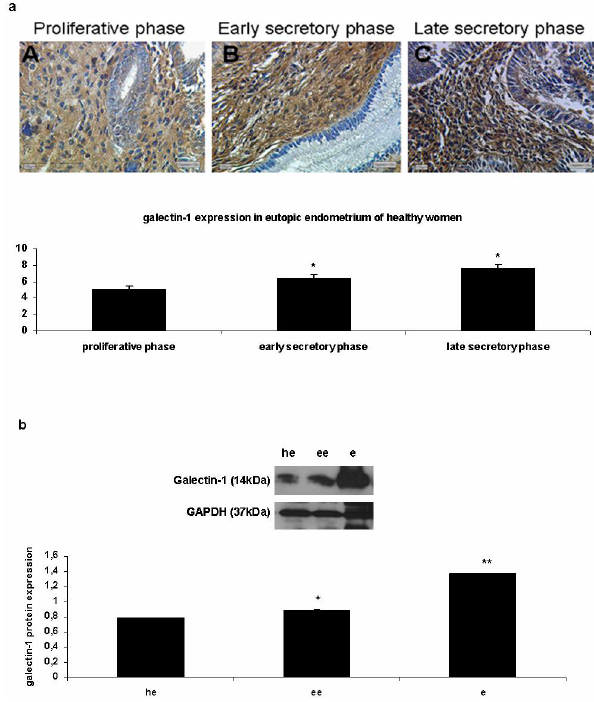
Figure 1. Galectin-1 overexpression in late secretory phase of eutopic endometrium and in endometriotic sites. 1a: Immunohistochemical expression of galectin-1 expression through the different phases of the menstrual cycle of the endometrium (A: proliferative, B: early secretory phase, C: late secretory phase) showing a higher expression pattern at the late secretory phase of the endometrium(C), *p , 0.05. 1b: Western blot immunodetection of galectin-1 (14 kDa) protein expression in eutopic and ectopic endometrium. Galectin-1 is overexpressed in eutopic endometrium of endometriotic women (ee) when compared to eutopic endometrium of healthy women (he), *p , 0.05 and galectin-1 shows an abundant expression in ectopic endometrium (e) when compared to eutopic endometrium of the same endometriotic women (ee), **p , 0.01. GAPDH (37 KDa) was used as a house keeping gene.